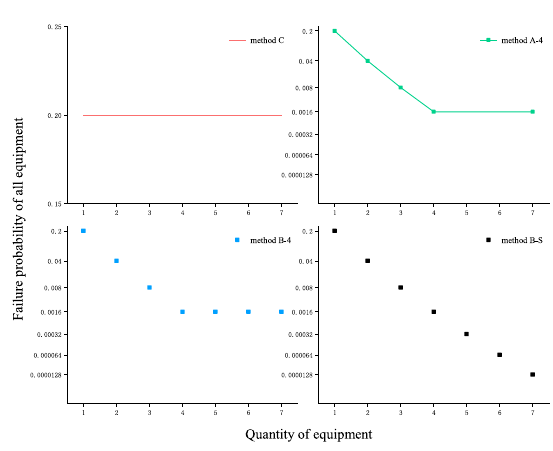
Fig. 7 The difference between different